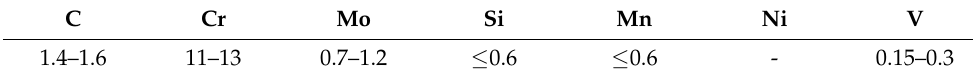
Table 1. The chemical composition of SKD11 steel (wt%)